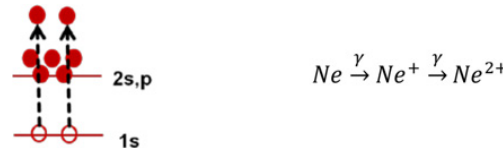
Figure 2. Two-photon single-site double core hole